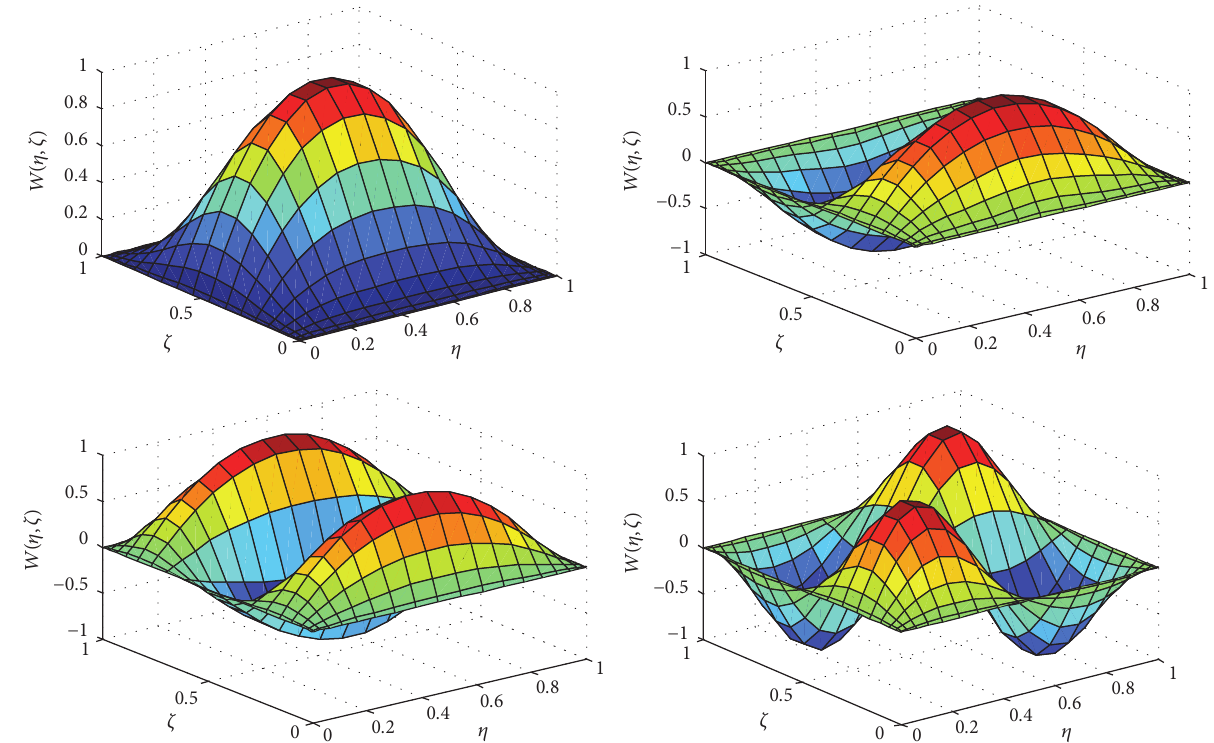
Figure 6: Deflection of porous plate versus porosity for four primary modes in (𝑒 1 = 0.2, 𝛼 = 0.2, 𝛾 = 1, SSSS ) .